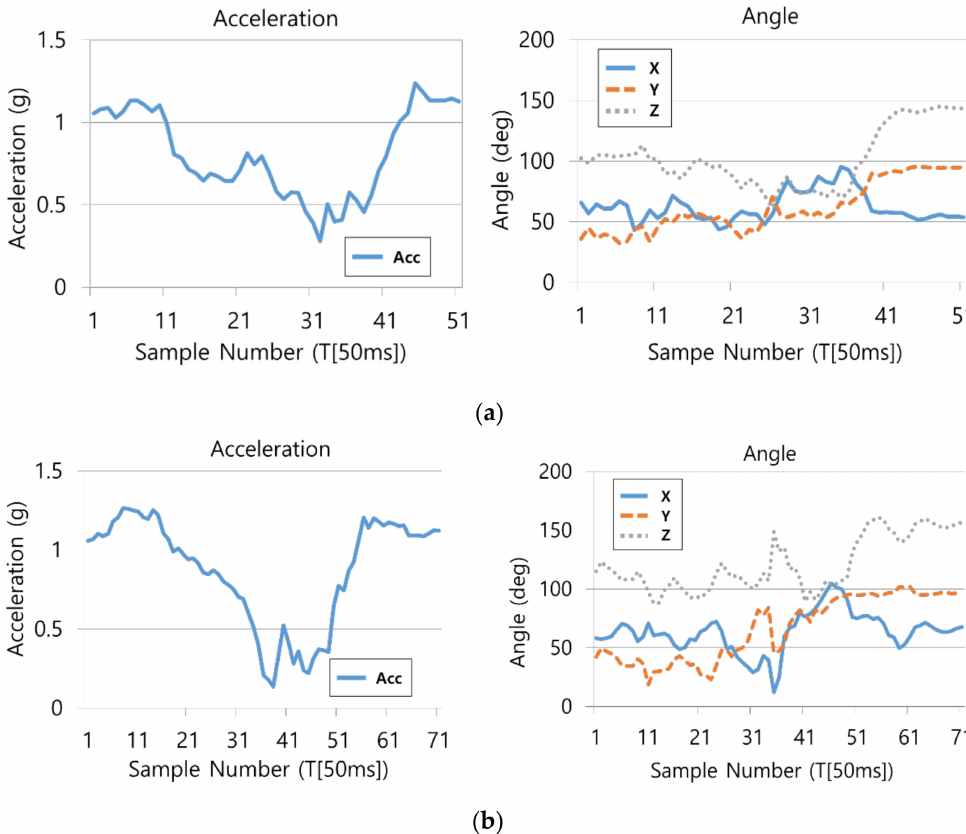
Figure 3. Similar graphs in the same accident situation(left collision): ( a ) accident 1; ( b ) accident 2.